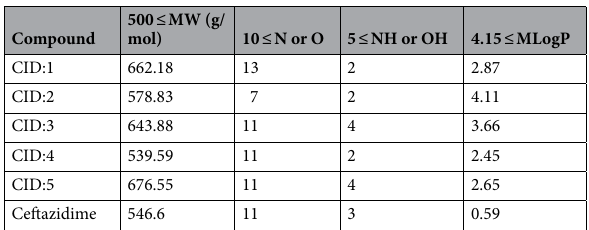
Table 4. Molecular weights (MWs), number of oxygen and nitrogen atoms, number of hydrogen bond acceptors (–H), and lipophilicity (LogP) of the selected compounds and the control.